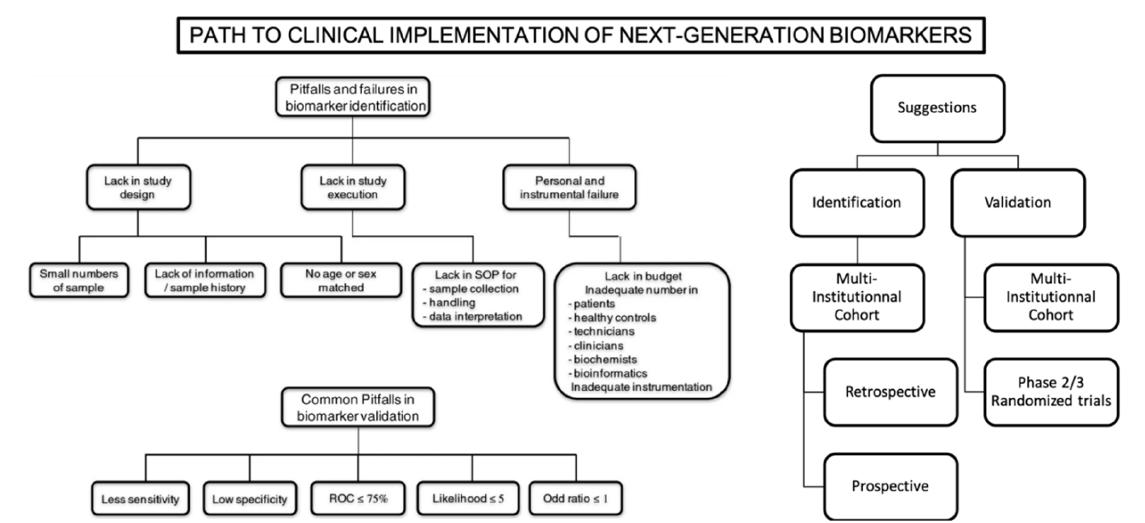
Figure 2. Main limitations and propositions for clinical implementation of next-generation biomarkers. Reproduced and adapted with permission from